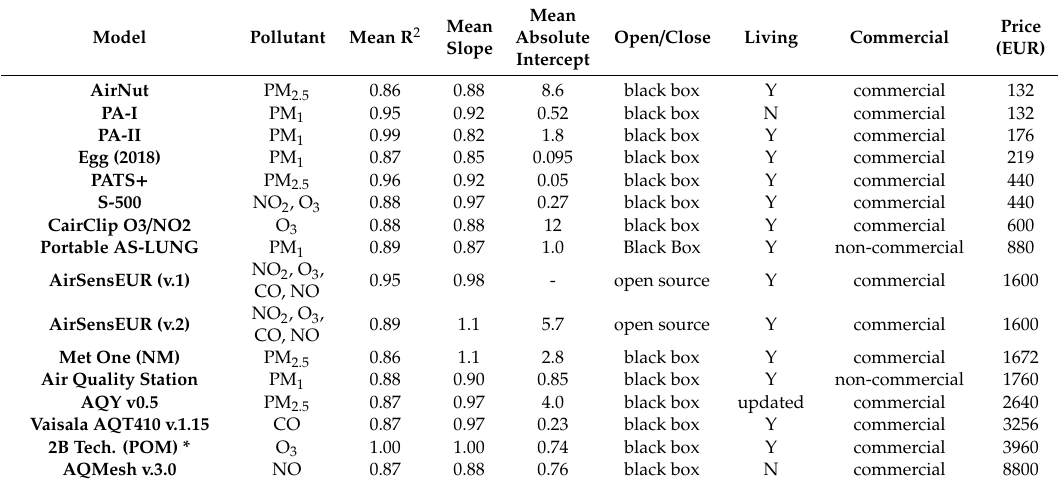
Figure 6. Price of low-cost SSys. Numbers in bold indicate the number of pollutants measured by open source (blue) and black box (black) sensors. Only records with R 2 > 0.85 and 0.8 < slope < 1.2 are shown. Names of “living” and “updated” and “non-living” sensors are indicated in black and red on the labels of the x-axis, respectively. NC indicates commercially unavailable sensor. Labels reporting hourly / daily indicate the averaging time of reviewed records. Table 4. Shortlist of SSys showing good agreement with reference systems (R 2 > 0.85; 0.8 < slope < 1.2) for 1 h time-averaged